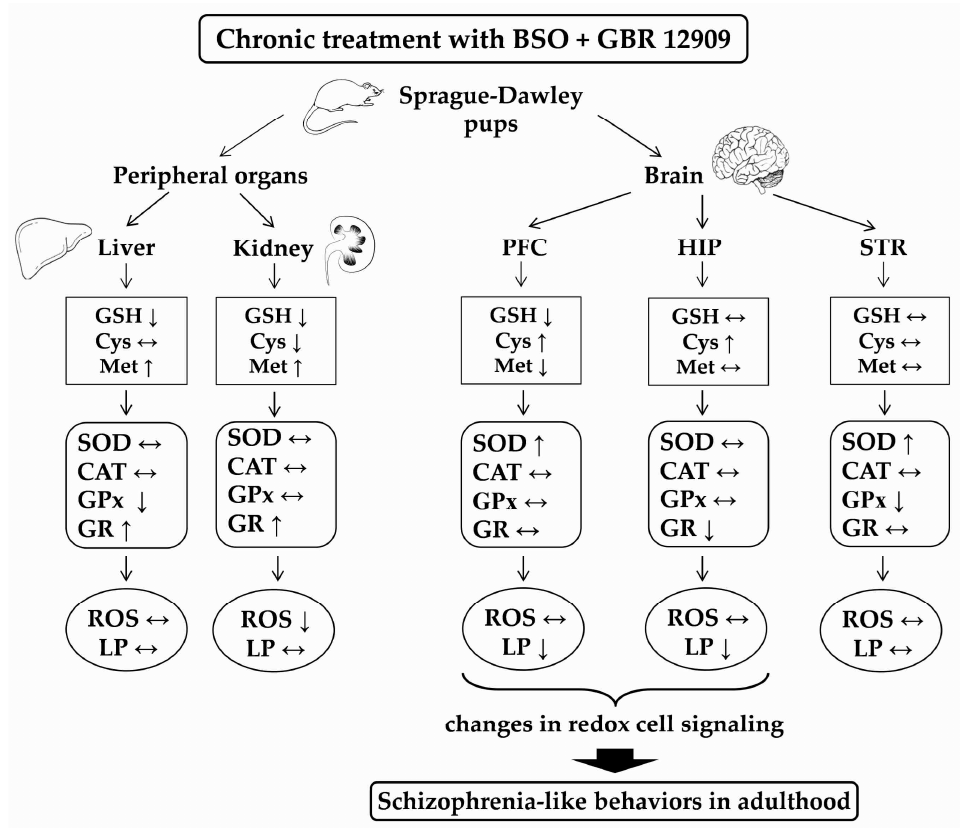
Figure 7. Graphic illustration of the observed changes in GSH, Cys and Met concentrations, antioxidant enzyme activities (SOD, CAT, GPx, GR), the total levels of ROS and lipid peroxidation (LP) in peripheral tissues (liver, kidneys) and selected brain structures (PFC, HIP, STR) of Sprague-Dawley pups treated at postnatal days 5-16 with BSO + GBR 12909 combination. Arrows show: ↑ – increase; ↓ – decrease; and ↔ – no changes in the studied parameters.